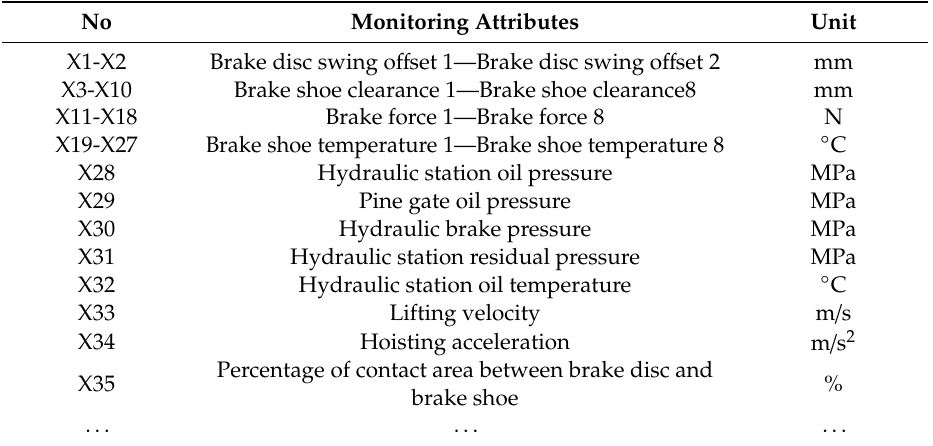
Table 1. Brake system monitoring